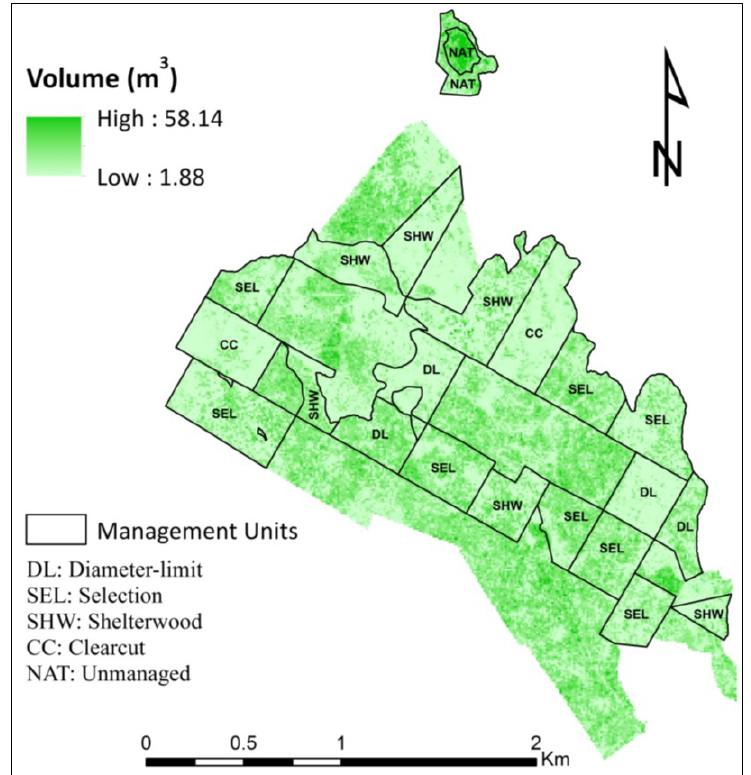
Figure 5. Volume (m 3 ha −1 ) distribution map over the Penobscot Experimental Forest (PEF). The prediction model was developed based on 117 research-grade plot data. Each grid represents 900 m 2